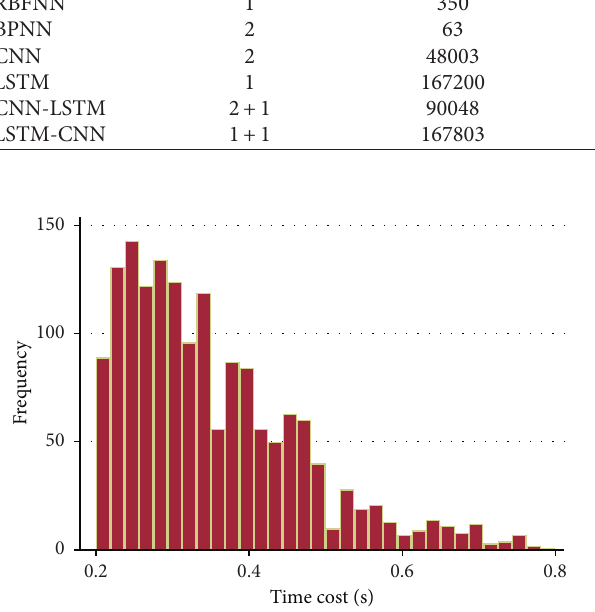
Figure 10: Time cost to obtain the correct prediction